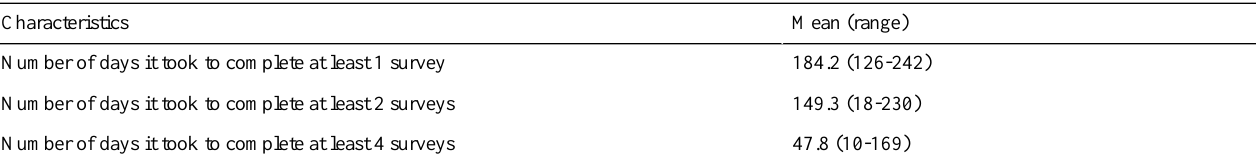
Table 4. Ecological momentary assessments and diary reports of the participants, including participants with delayed 6-month follow-up assessments who continued the ecological momentary assessments and diary.